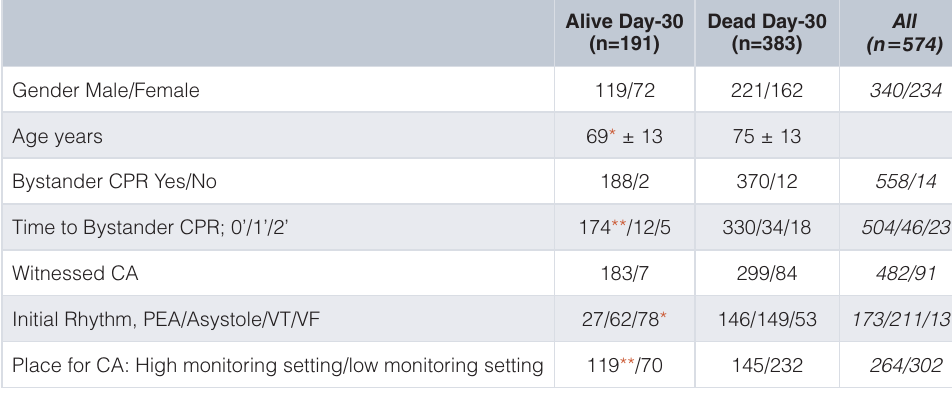
Table 1. Factors with impact on successful outcome of resuscitation of in-hospital cardiac